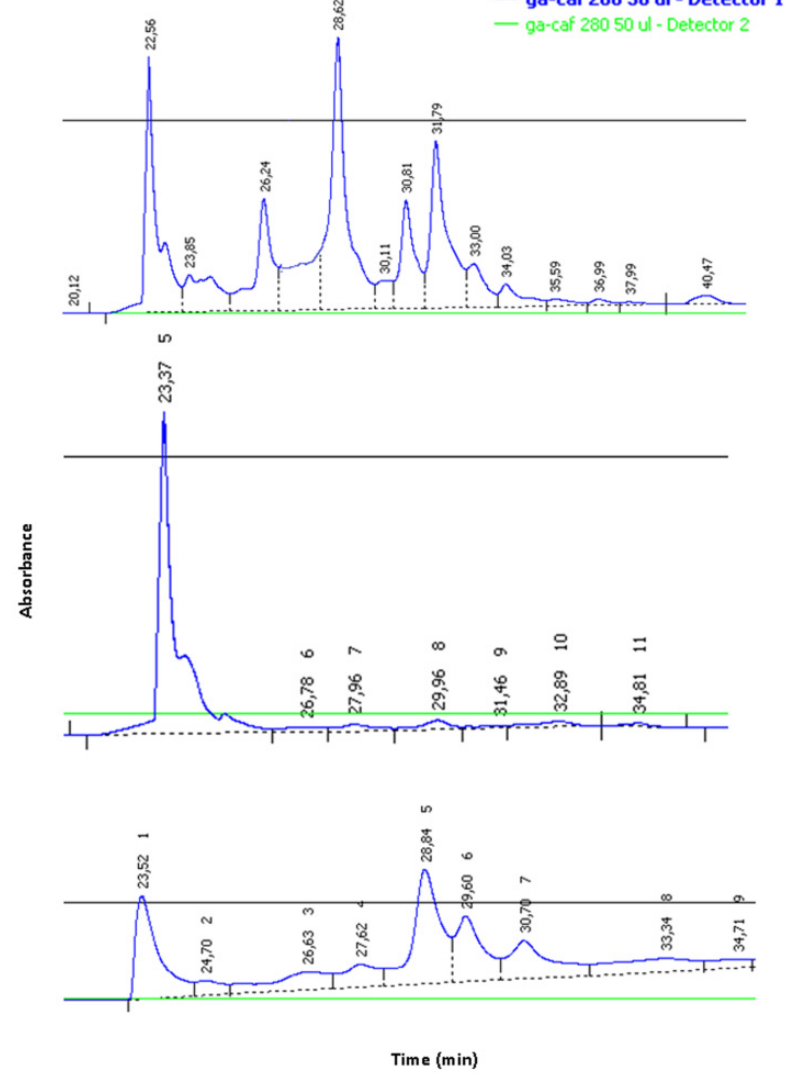
Figure 3. HPLC profile of 1 . Crude mixture ( a ), isolated conformer ( b ), re-established mixture of rotamers ( c